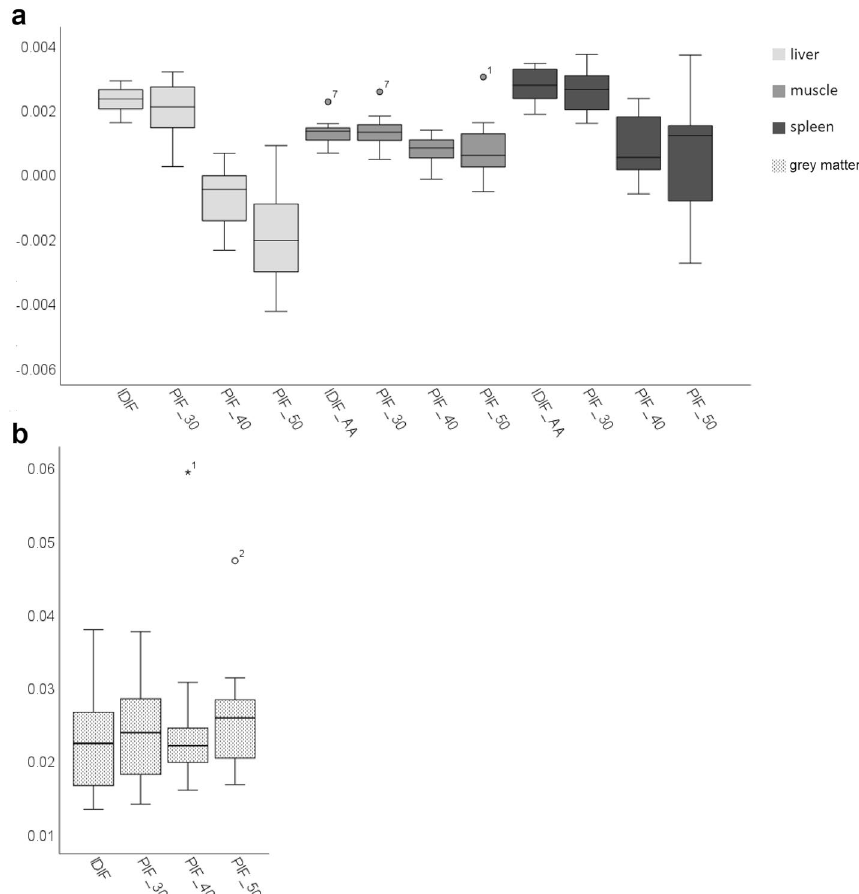
Fig. 6 Healthy tissue K i obtained using the IDIF compared with K i obtained with the PIF scaled to the IDIF at scan time interval 30–60 min p.i. (PIF_30), 40–60 min p.i. (PIF_40), and 50–60 min p.i. (PIF_50). Mild outliers are marked with a circle and are data points that fall outside quartile1 ( Q 1 ) − 1.5 ∗ interquartilerange ( IQR ) or Q3 + 1.5 ∗ IQR . Extreme outliers are marked with an asterisk and fall outside Q1 − 3 ∗ IQR or Q3 + 3 ∗ IQR . For readability, axes were scaled differently for liver, spleen, and muscle K i ( a ) with respect to grey matter K i ( b